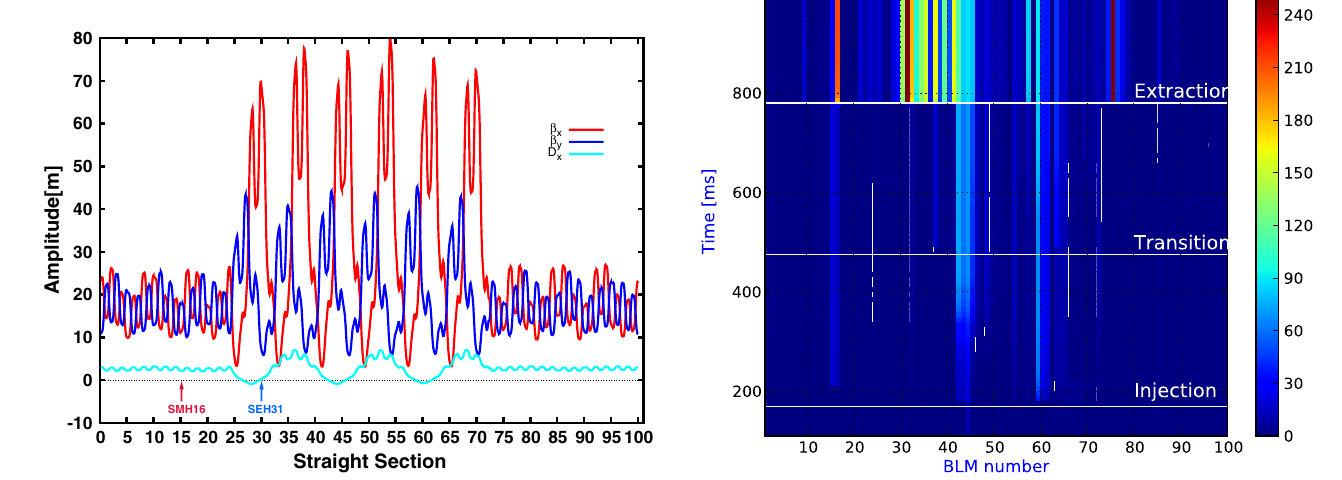
FIG. 20. BLM integrated measurement for the CNGS beam with the new optics scheme. Losses in SS05-09 have been displaced to a better-shielded region in